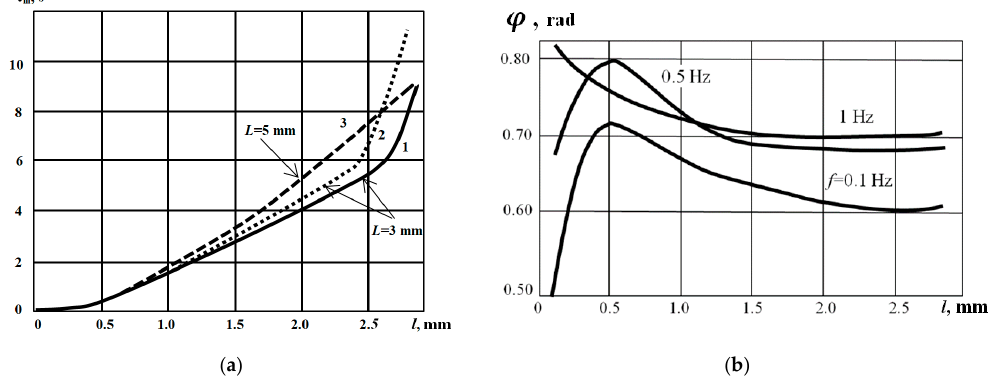
Figure 2. Dependence of optimum observation time τ m ( a ) and thermal wave phase ϕ ( b ). on defect depth l in the inspection of CFRP (CFRP thermal properties: thermal conductivity 0.64 W · m − 1 · K − 1 , diffusivity 5.2 · 10 − 7 m 2 · s − 1 , L = 3 and 5 mm, defect size 10 × 10 × 0.05 mm, 1, 3—numerical modeling, 2—analytical solution).